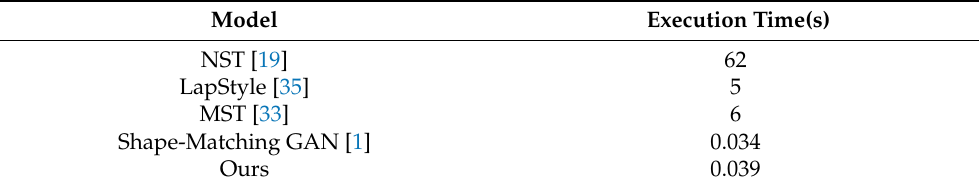
Table 1. Execution time